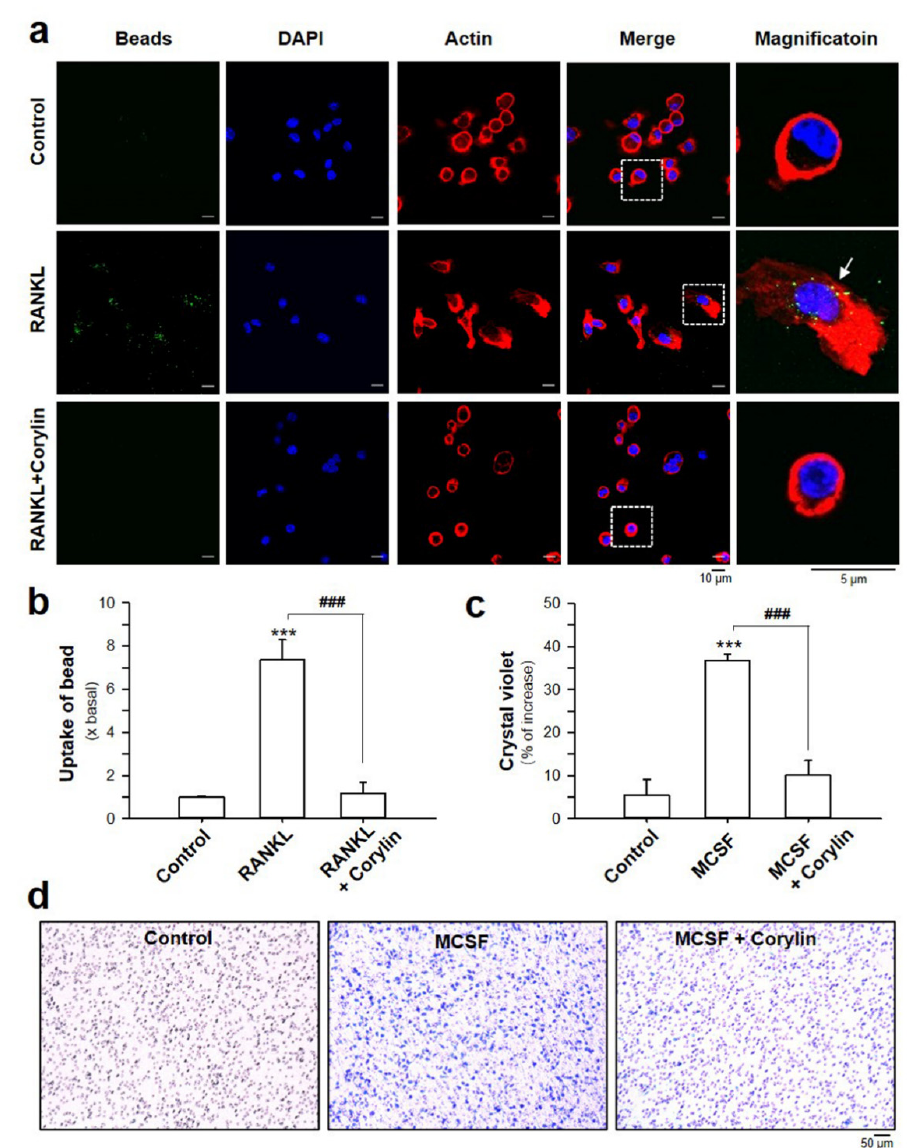
Figure 3. Corylin attenuates the phagocytosis and cell migration of pre-osteoclasts. ( a ) Bone marrow macrophages were prepared on glass coverslips, preincubated for 30 min with or without corylin (5 μ M), and incubated for 40 min with fluorescent latex beads. Bone marrow macrophages were then fixed and stained with F-actin (red) and DAPI (blue) before observing by fluorescent microscopy. In the magnification picture, arrows indicate the bright green, fluorescent latex bead incorporated into the cell. ( b ) Phagocytic activity was expressed as the uptake of beads, calculated from the intensity of green fluorescent. ( c ) Quantification data of the effect of corylin on the cell migration from in vitro trans-well migration assay. ( d ) Representative images of crystal violet staining for migrated cells. Cells were seeded on the upper side of the trans-well membrane. Cell culture medium without fetal bovine serum (FBS) and conditioned medium (completed medium plus 30 ng/mL MCSF) were added to the lower chamber as the negative control and chemo-attractant, respectively. The value is expressed as mean ± SD, n = 3–4. *** p < 0.001, compared with control; ### p < 0.001, compared with RANKL-treated control.